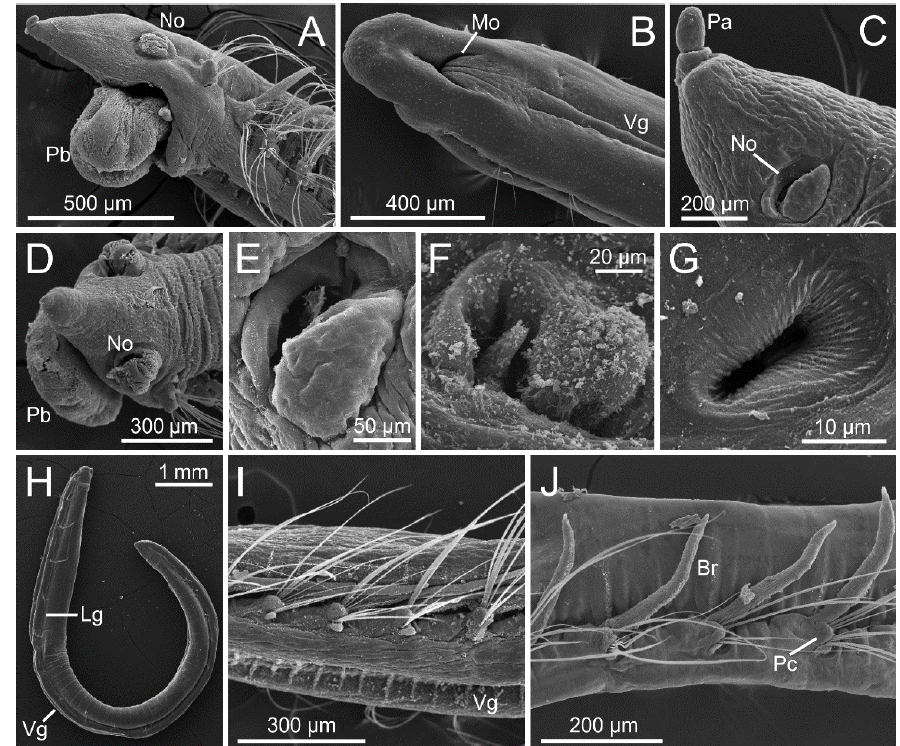
Figure 4. SEM micrographs of several Opheliidae showing main diagnostic characters. ( A ) Ophelina breviata , anterior end in lateral view, showing pointed prostomium; ( B ) Polyophthalmus pictus , anterior end in ventral view, showing the distally rounded prostomium; ( C ) Ophelina helgolandiae , anterior end in lateral view; ( D ) O. breviata , anterior end in dorsal view; ( E ) O. helgolandiae , nuchal organ; ( F ) Armandia buccina , nuchal organ; ( G ) Ophelina abranchiata , nuchal organ; ( H ) O. abranchiata in lateral view; ( I ) A. buccina , anterior chaetigers in lateral view; ( J ) Armandia opisthoculata , mid-body chaetigers in lateral view. Abbreviations: Br—branchia; Lg—lateral groove; Mo—mouth; No—nuchal organ; Pa—palpode; Pb—proboscis; Pc—prechaetal lobe; Vg—ventral